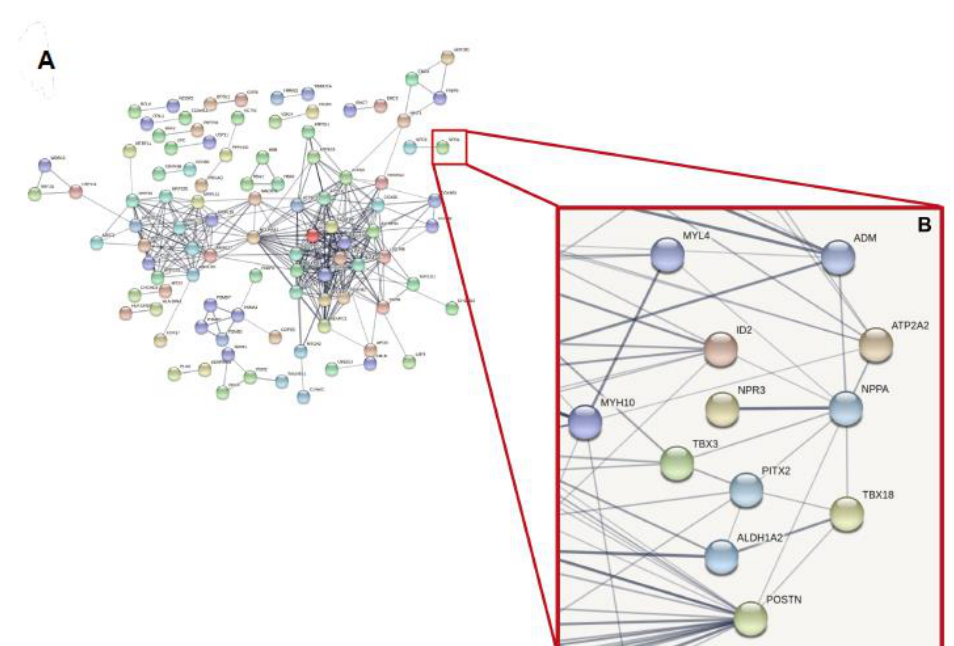
Figure 5. Protein – protein interaction networks functional enrichment analysis for the differential expressed genes and NPPA gene selected from correlation analysis with clinical features. ( A ) Physical interaction with a STRING score > 0.7; ( B ) non-physical interaction (from text mining and databases) of NPPA with differential expressed genes.